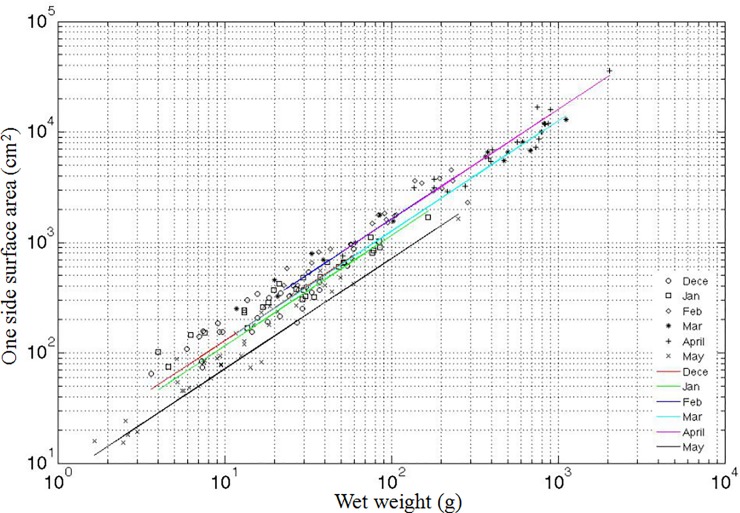
Log plot of wet weight (W) (g) versus one-sided surface area (S) (m2) from December 2014 to May 2015.Solid lines are regression fits. Correlations in December 2014 (S = 12.818 × W, r2 = 0.91, p < 0.001), January 2015 (S = 11.543 × W, r2 = 0.98, p < 0.001), February 2015 (S = 16.215 × W, r2 = 0.67, p < 0.001), March 2015 (S = 12.62 × W, r2 = 0.64, p < 0.001), April 2015 (S = 16.05 × W, r2 = 0.96, p < 0.001) and May 2015 (S = 7.1355 × W, r2 = 0.97, p < 0.001).